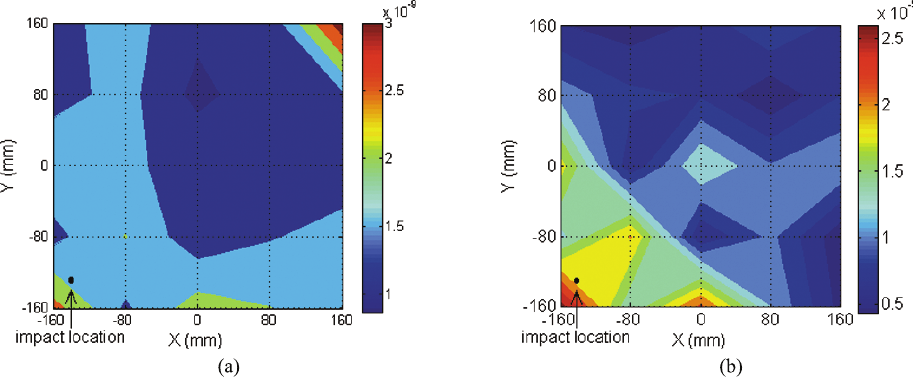
Fig. 5. Initial search results of impact #2 (a) Selecting the peak value during time period T (b) Selecting the peak value during time period T 1 . transfer function and time spent in computation. The spacing of the calibration locations is chosen from 20 mm to 80 mm by 20 mm in spacing